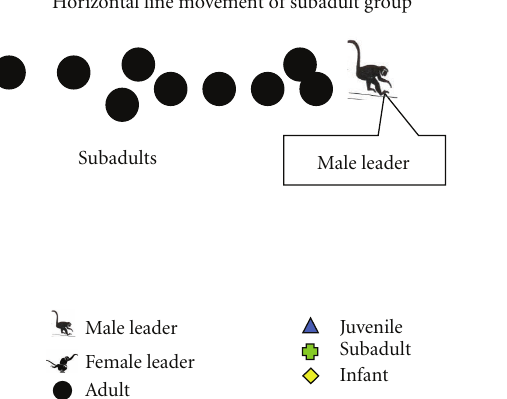
Figure 3: The horizontal cross- and horizontal line movement of P . c .